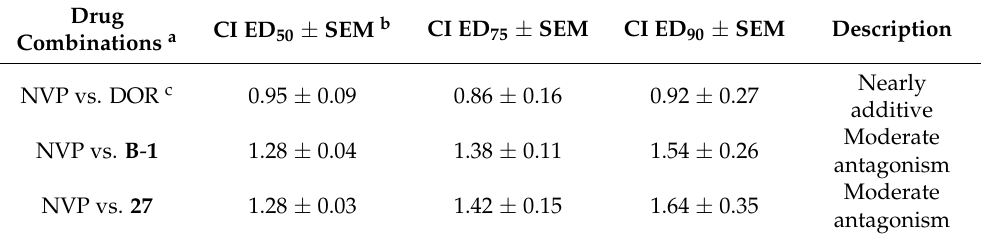
Table 3. Compounds B-1 and 27 in combination with nevirapine antagonistically inhibit HIV-1